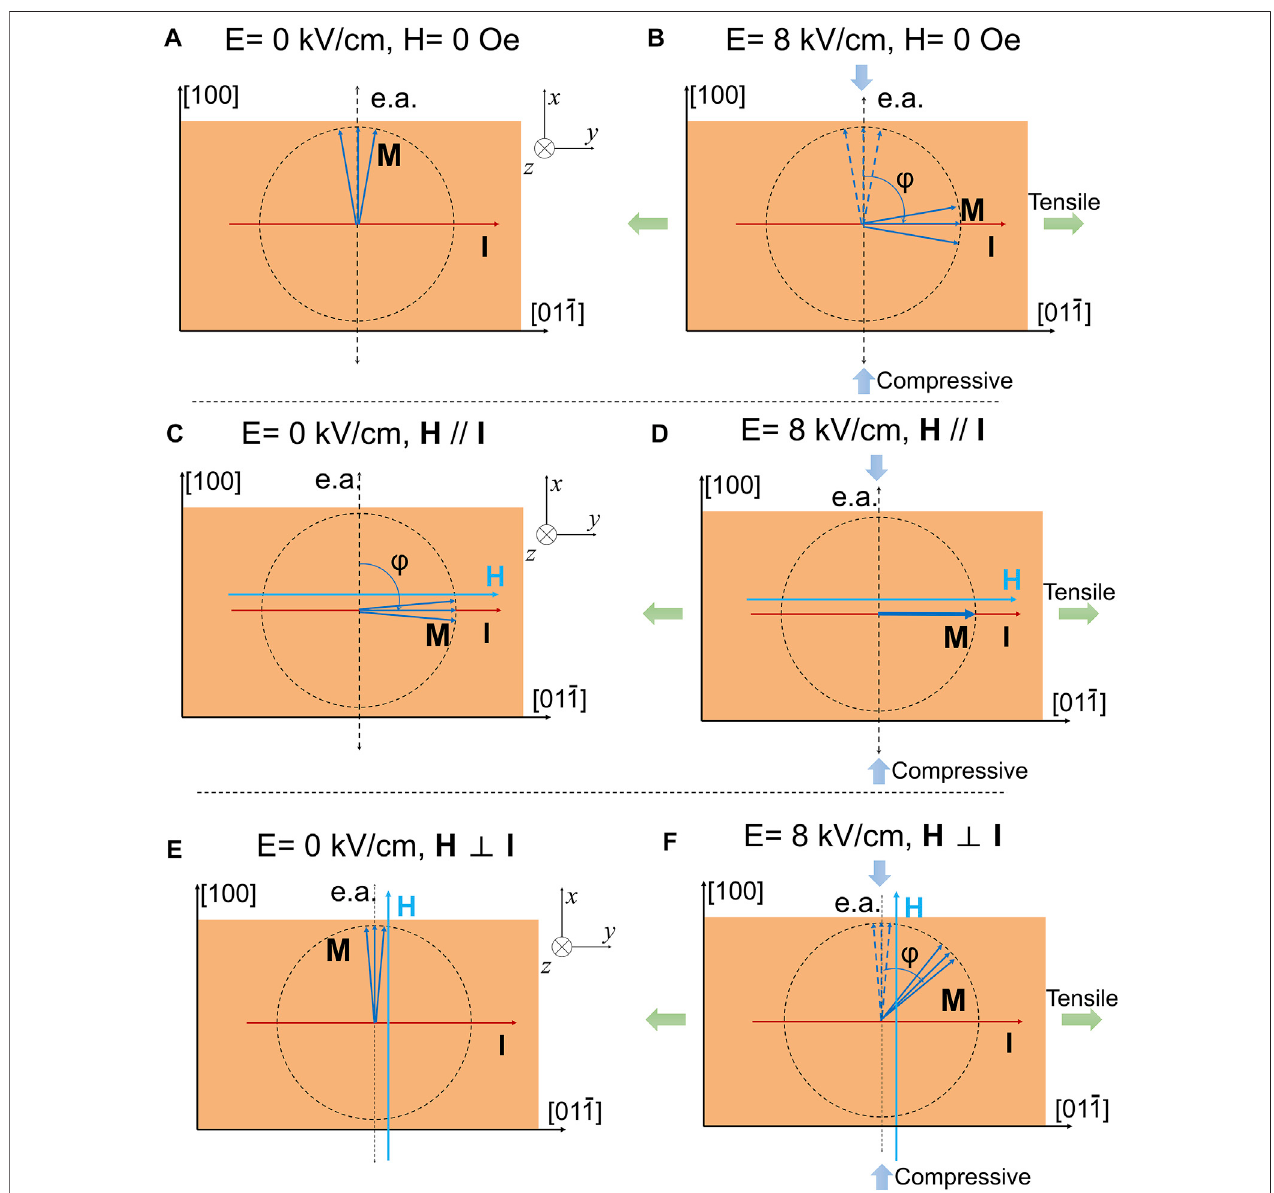
FIGURE 6 | (A) Schematic of the initial magnetic state of the Conetic alloy thin fi lm/PMN – PT multiferroic heterostructure. (B) Schematic of magnetization rotation induced by E- fi eld-induced tensile and compressive strains without magnetic fi eld bias. Wide, light blue and green arrows represent in-plane anisotropic compressive andtensilestrains,respectively. (C) and (D) Schematicsofmagneticstatesat0and8 kV/cm,respectively,withthemagnetic fi eldperpendiculartocurrent ( I ) . (E) and (F) Schematics of magnetic states at 0 and 8 kV/cm, respectively, with the magnetic fi eld parallel to current ( I ) . Light blue, dark blue and dark red arrows represent magnetic fi eld H, magnetization M and applied current I, respectively. The thick, dark blue arrow in Panel (D) means that the magnetization is almost aligned along the [01 1] direction of the PMN-PT under application of E- fi elds.